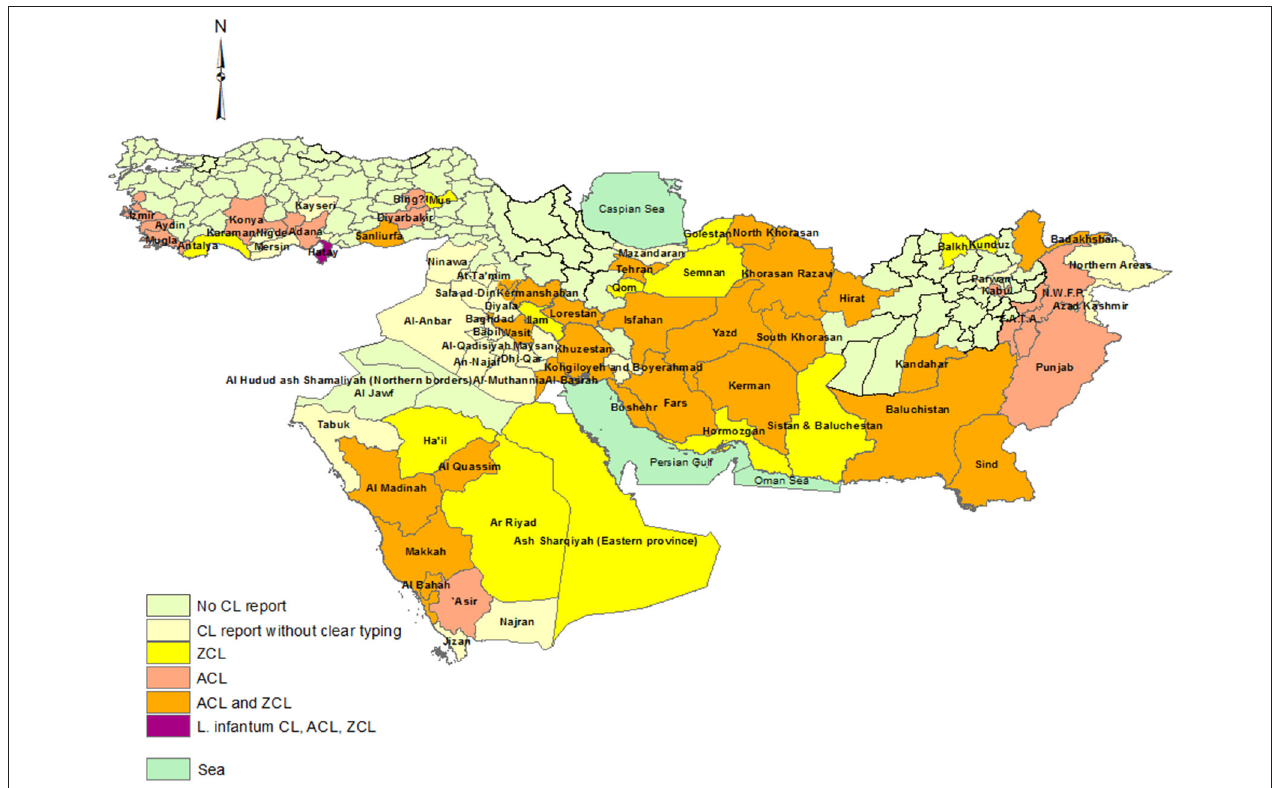
FIGURE 7 | Distribution of CL types in the part of Middle East including Turkey, Iraq, Iran, Saudi Arabia, Afghanistan, and Pakistan in a